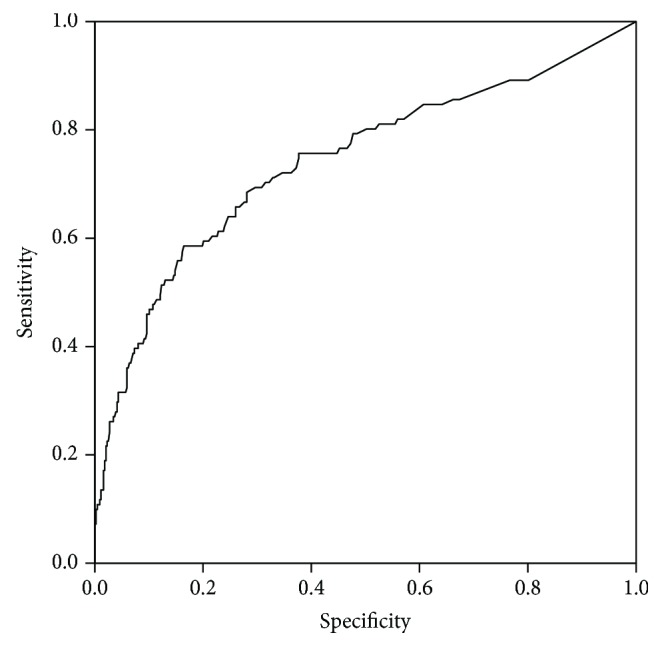
ROC curve of A-hTG in PTC patients.